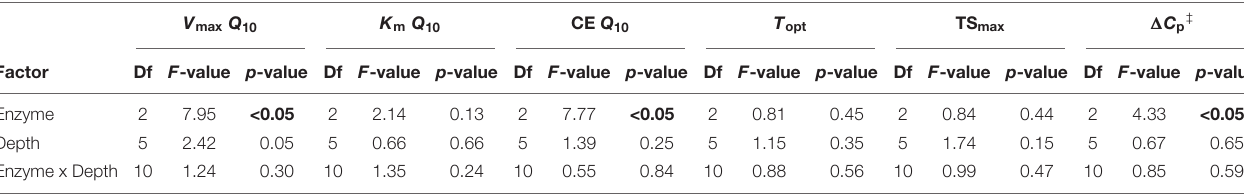
FIGURE 8 | Macromolecular Rate Theory (MMRT) model estimates over six temperatures from 4 to 50 ◦ C at different depths. (A) T opt , (B) TS max , and (C) (cid:49) C p ‡ . Differences between depths are not significant ( p > 0.05), based on one-way ANOVA tests per enzyme ( Table 4 ), except for TS max of LAP between the depths indicated by asterisks (*). Error bars represent the standard error of the mean ( n = 3). TABLE 5 | Two-way fixed effects ANOVA of temperature sensitivity estimates with enzyme type and depth as independent